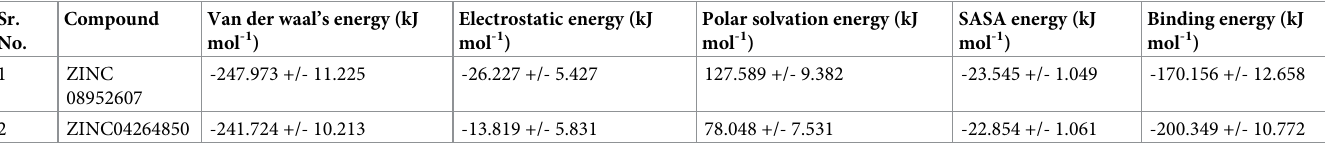
Table 3. Van der Waal’s, electrostatic, polar salvation, SASA and binding energy in kJ/mol for top two complexes. Sr.